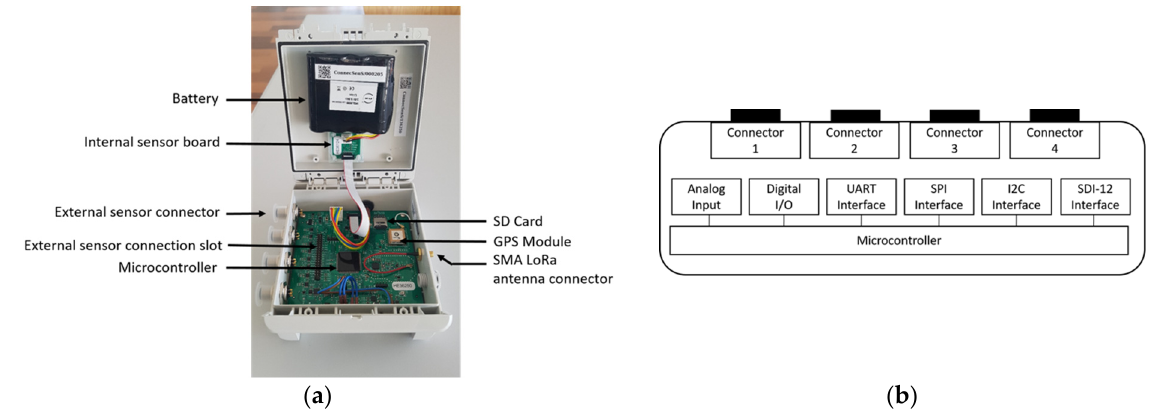
Figure 4. Electronic features of the SoLo node. ( a ) Electronic boards and batteries inside the box of the SoLo node. ( b ) Synoptic of the SoLo node I/O interface.